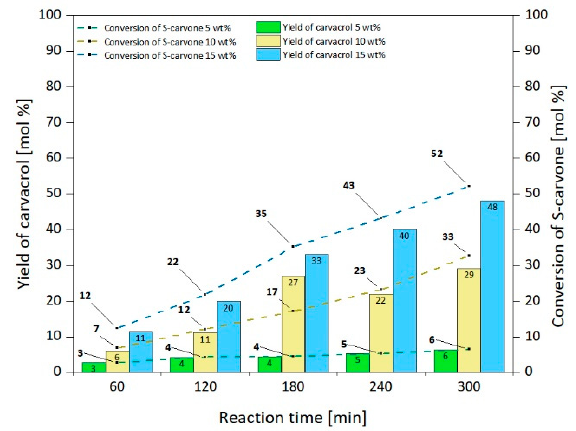
Figure 13. Influence of the reaction time and catalyst content on the conversion of S-carvone and the yield of carvacrol at 190 °C. (The experimental error was 1 mol%.)